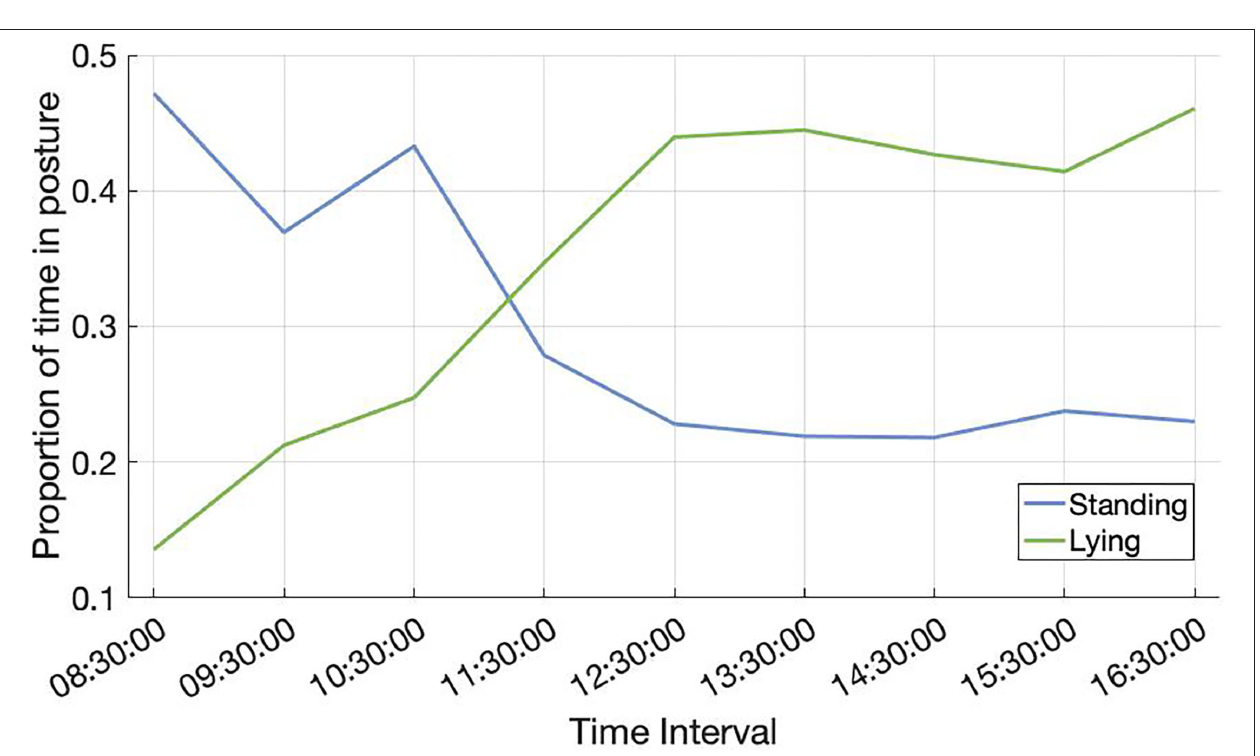
FIGURE 6 | Proportion of time spent standing (blue) and lying (green) as a function of time over the day. The proportion in each posture was computed with the data from all animals, with no distinction of breed.